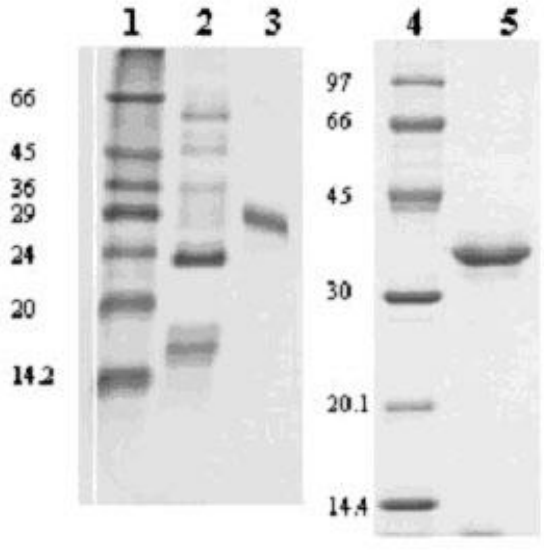
Figure 2. SDS-PAGE analysis of the purified enzymes. The purified enzymes were subjected to electrophoresis in a 14% sodium dodecylsulfate polyacrylamide gel under reducing conditions. Lanes 1 and 4: Molecular weight markers; Lane 2: Bothrops alternatus venom; Lane 3: reduced BaltMP-I; Lane 5: reduced BaltMP-II. Electrophoresis was carried out at 20mA/gel in Tris-glycine buffer, pH 8.3, containing 0.01% SDS. The slab gel was stained with Coomassie Blue R-250 and destained with methanol : acetic acid : water (1 : 5 : 5,